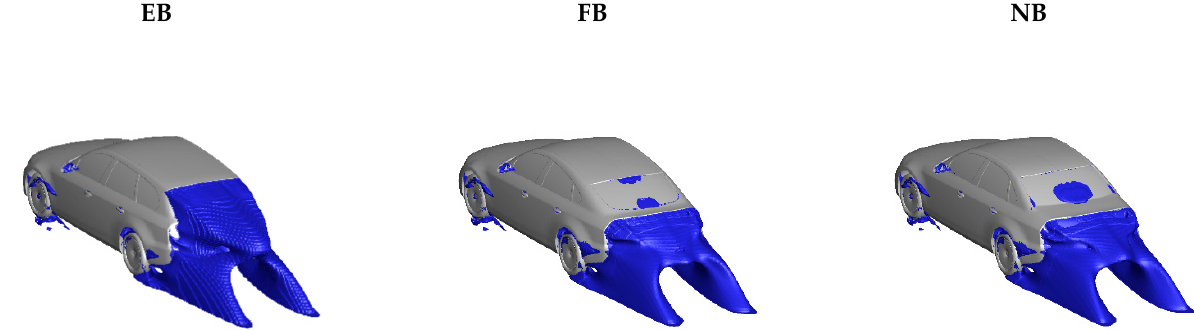
Figure 4. CFD results of the three-dimensional wake structure of the three baseline configurations represented with iso-surfaces of the velocity magnitude below 5 ms − 1 .